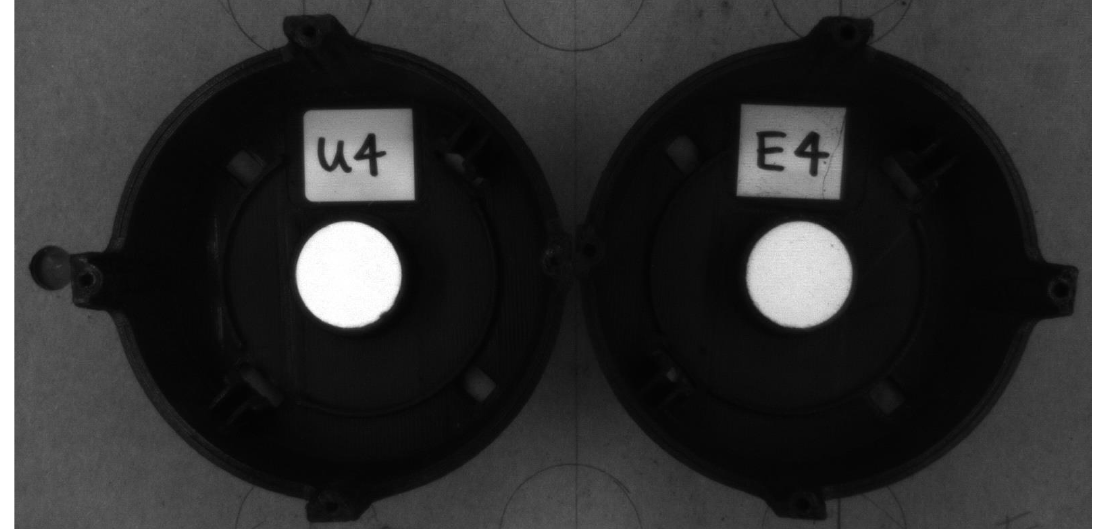
Figure A3. Image layout detail with a reference sampler (on the left; “U4”) and sample (experimental) sampler (on the right; “E4”), side-by-side, inside the lightbox. Samplers shown here, which are the same as in Figures A1c and A2b, differ slightly from the final design; the largest difference is use here of transparent double-sided tape rather than a threaded clamp (Figure 1g) to attach the paper surface to the plastic backing.